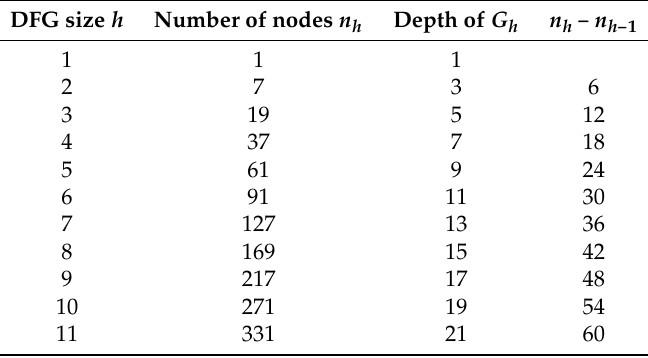
Table 3. Variables for each